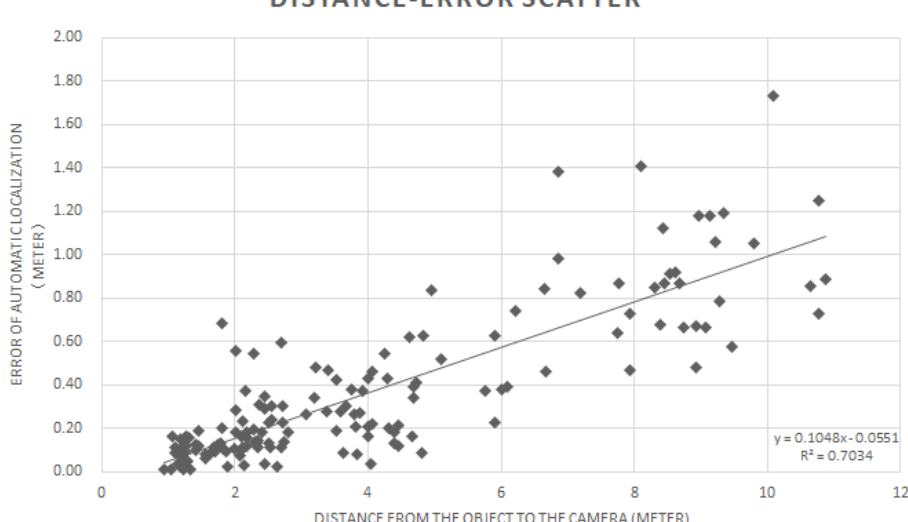
Figure 7. Scatter map of the relationship between the camera–object distance and localization error.